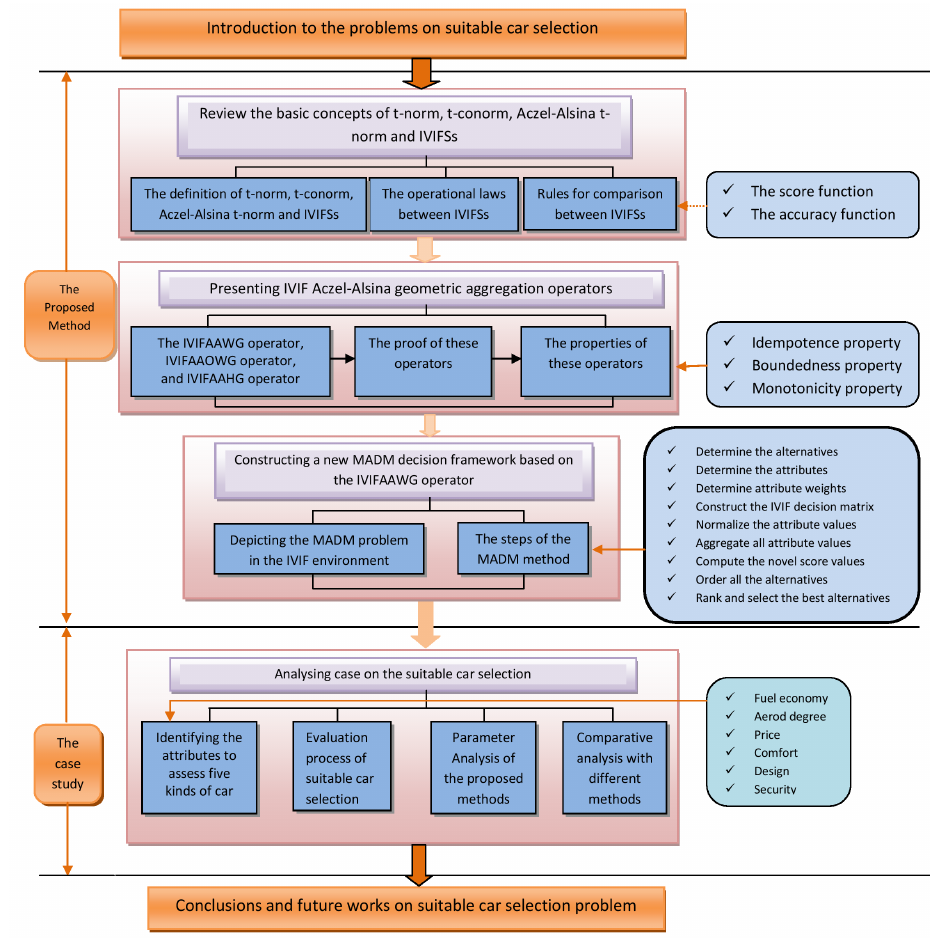
Figure 1. The framework of the